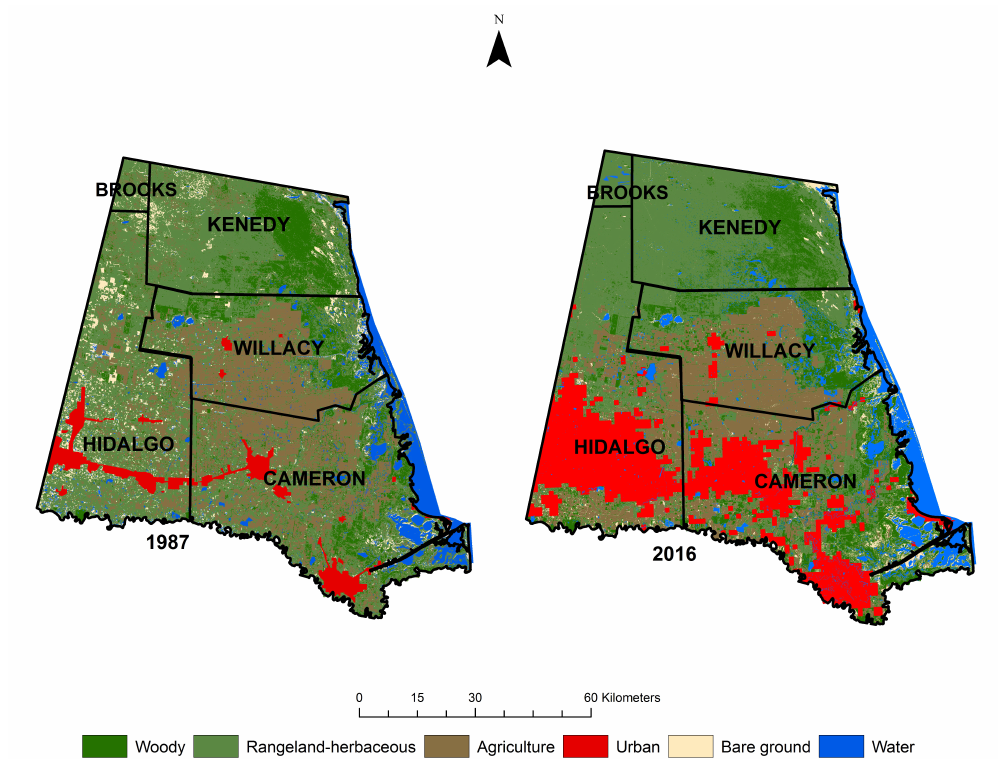
Figure 7. Comparison of 2016 land cover types (i.e., woody, rangeland-herbaceous, agriculture, urban, bare, and water) and projected land cover in 2050 (based on the US Environmental Protection Agency’s rapid economic development, slow population growth and high global integration housing density scenario [A1]) in the Rio Grande Delta and surrounding rangeland study area (10,065 km 2 ) in South Texas, United